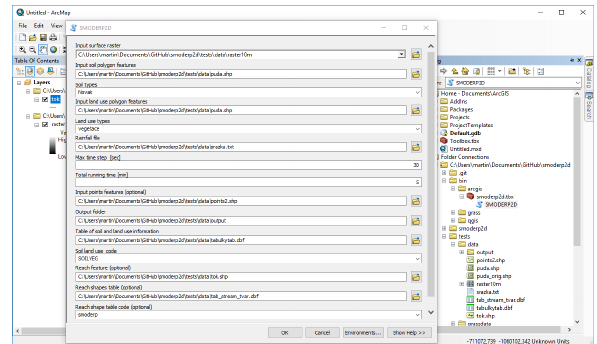
Figure 6. SMODERP2D model available as ArcToolbox for Esri ArcGIS 10.x and Pro